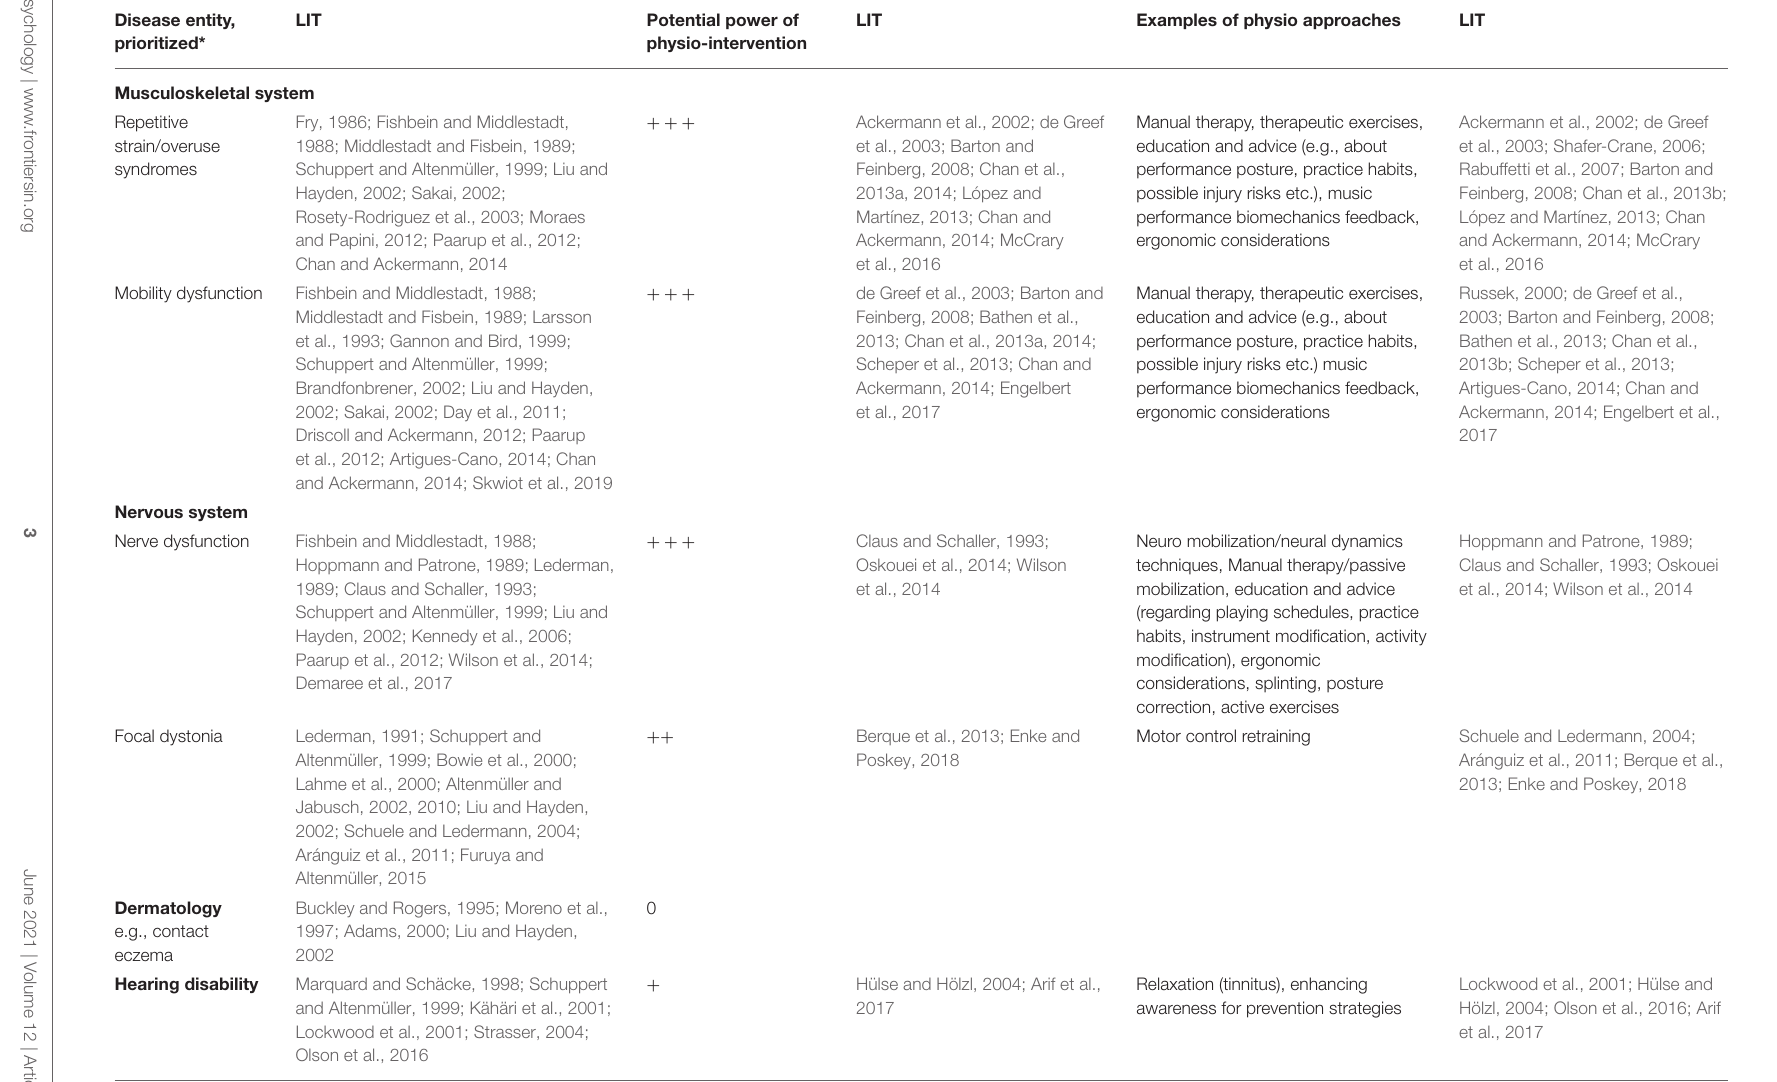
TABLE 1 | Work-related strain and disorders in musicians and physical therapy approach presented in an earlier version by the first author of this article at the 29th Annual Symposium of the Performing Arts Medicine Association, PAMA in Snowmass/CO 22.07.11 (“A physio clinic for musicians – outcome of the first 200 cases”). Disease entity, LIT Potential power of prioritized* physio-intervention